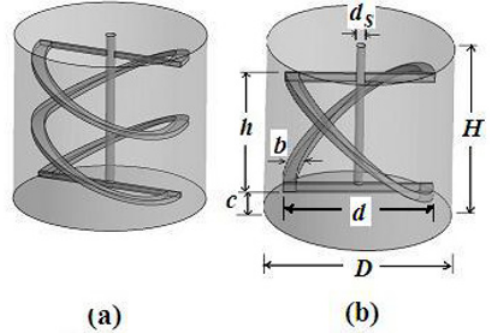
Figure 1. Agitation system: a) double helical ribbons; b) simple heli- cal ribbon.